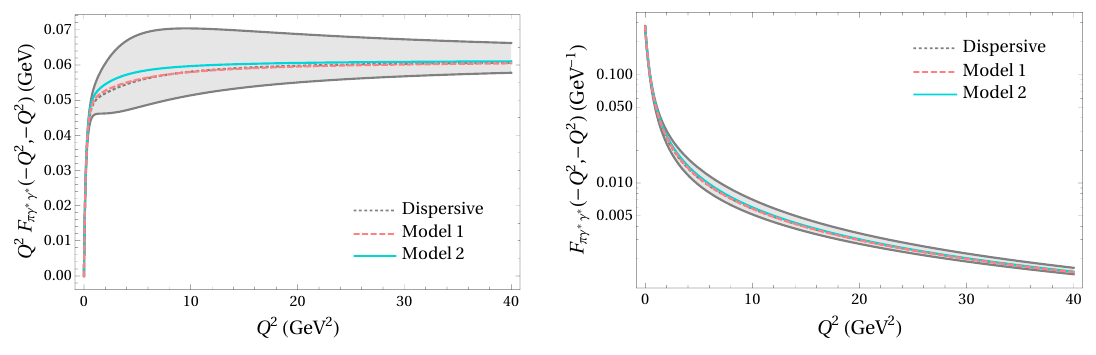
= Q 2 = Q 2 for Q 2 2 [0 ; 40] GeV 2 . 1 2